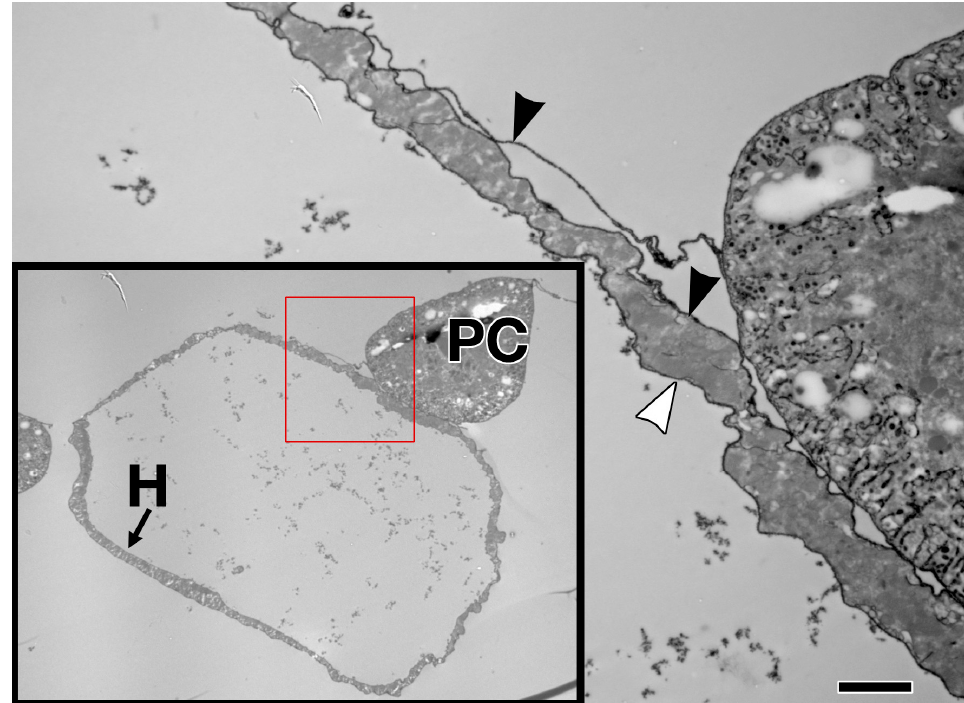
Figure 2. Extracellular matrix in the larval Drosophila heart. Enlargement of the cross section shown within the red box (lower left) reveals Ruthenium Red-labelled ECM proteoglycans on both the external (black arrowhead) and luminal (white arrowhead) surfaces of the heart muscle cell, with no endothelium. H: heart muscle; PC: pericardial cell. Scale bar is 2.0 microns.